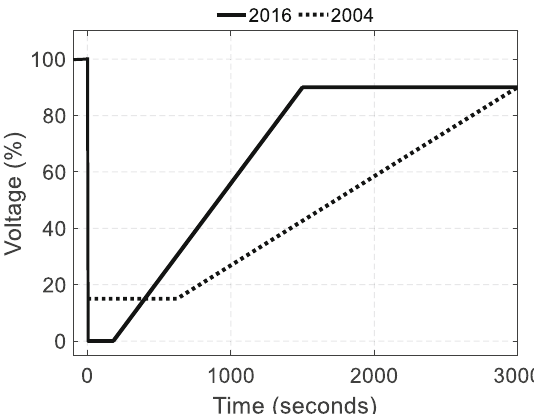
Fig. 1 the evolution of LVRT the requirement between 2004 and 2016 for the German power grid